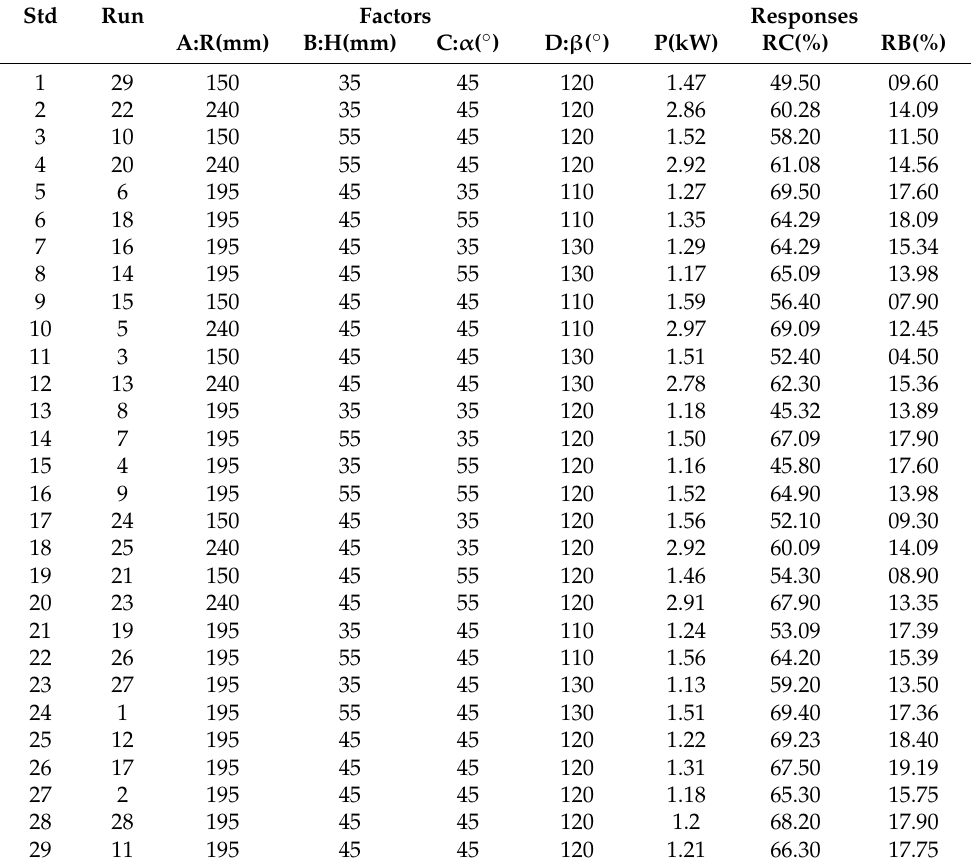
Table 6. Design and results of Box-Behnken